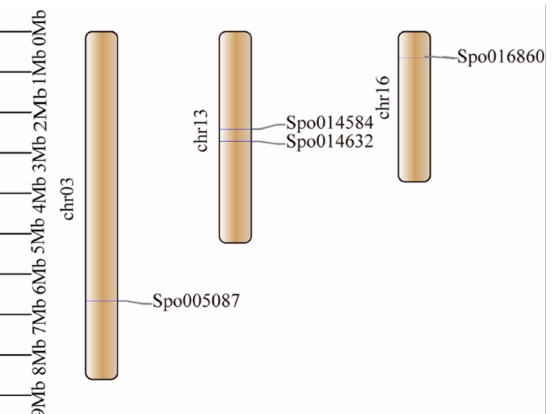
Figure 3. Distribution of SpNramp gene family on the chromosomes of S. polyrhiza . chromosome numbers are shown at the left of chromosome. SpNramp genes are labeled at the right of the chromosomes. Scale bar on the left indicates the chromosome lengths (Mb).